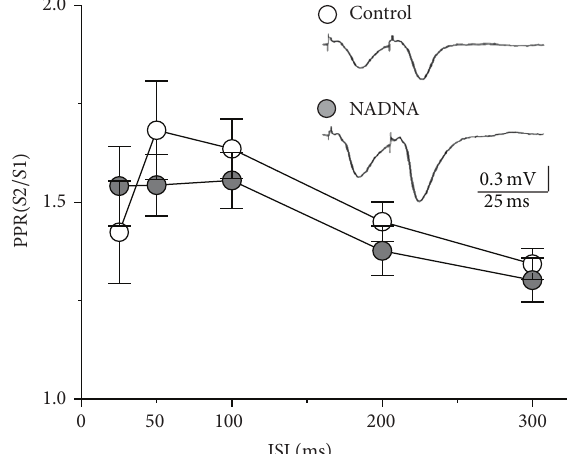
Figure 3: NEU inhibition does not influence paired-pulse plasticity in CA1 region of hippocampus. Histogram of average paired-pulse ratios as a function of ISI in control (white) and NADNA-pretreated (grey) slices. There were no significant differences between groups. Insets: averaged sample records of fEPSP at CA3–CA1 synapses measured at 25 ms ISI. All data are presented as Mean ±